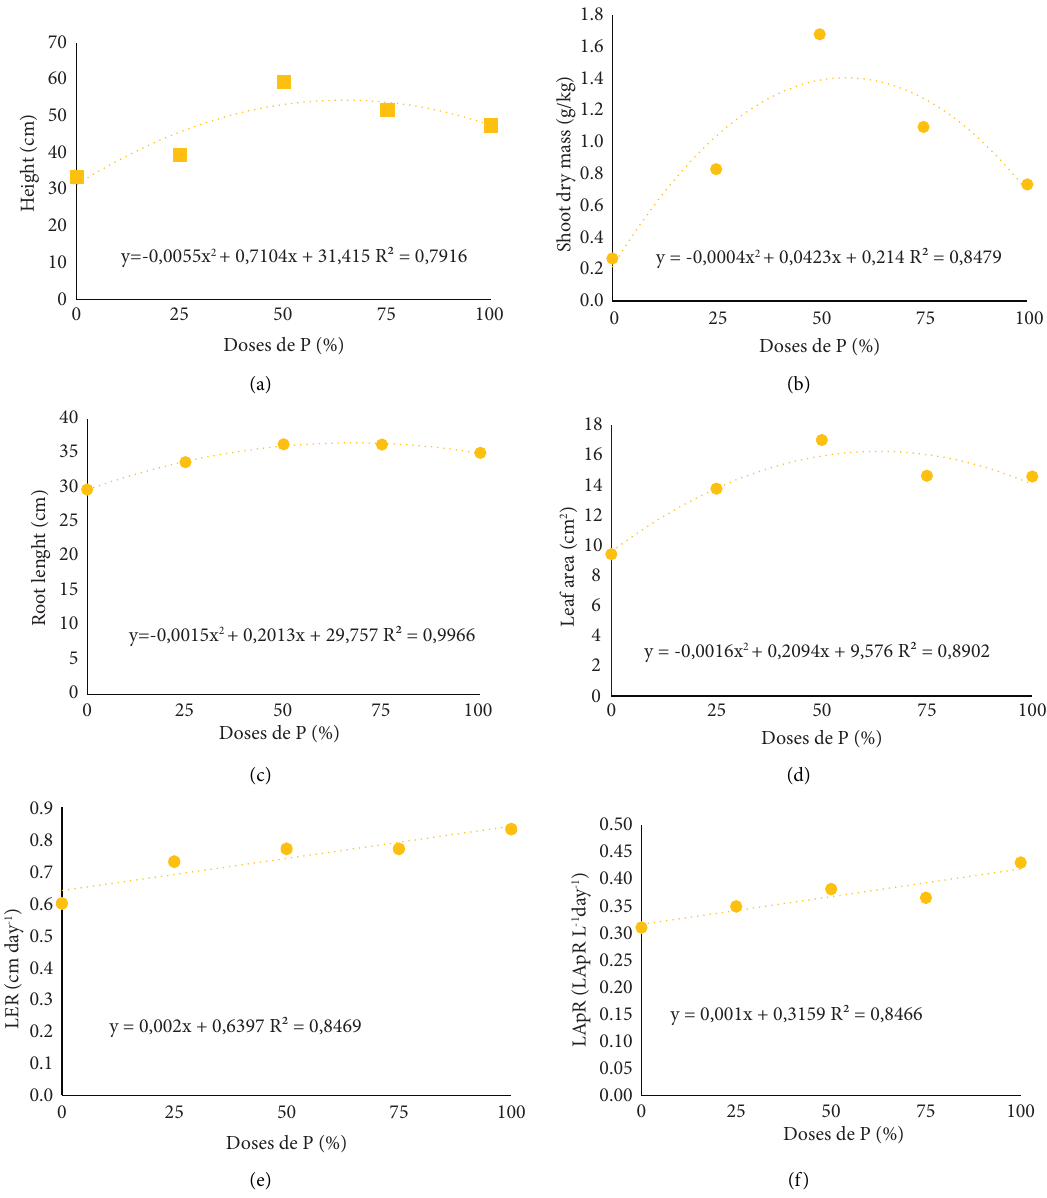
Figure 5: Isolated efect of reduced phosphorus doses on height (a), shoot dry mass (b), root length (c), leaf area (d), leaf elongation rate (e), and leaf appearance rate (f) of Urochloa brizantha cv.